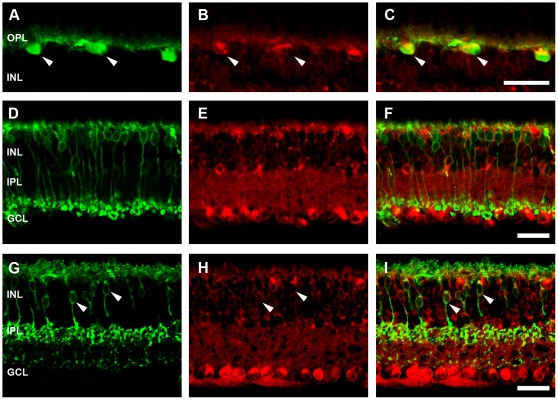
APP-immunoreactivity (IR) in the WT mouse retina colocalises with horizontal cells and cone bipolar cells but not rod bipolar cells.Immunohistochemistry on a transverse retinal section from an adult WT mouse for (A) horizontal cells labelled with Calbindin, and (B) APP-IR, showing (C) colocalisation. Immunohistochemistry for (D) rod bipolar cells labelled with PKCα and (E) APP-IR, showing that the markers do not colocalise (F). Immunohistochemistry for (G) cone bipolar cells (Type 2 and 6) labelled with a ZNP-1 and (H) APP-IR, showing (I) colocalisation. Arrows indicate examples of colocalisation. Outer plexiform layer (OPL), inner nuclear layer (INL), inner plexiform layer (IPL) and ganglion cell layer (GCL). Scale, 50 microns.